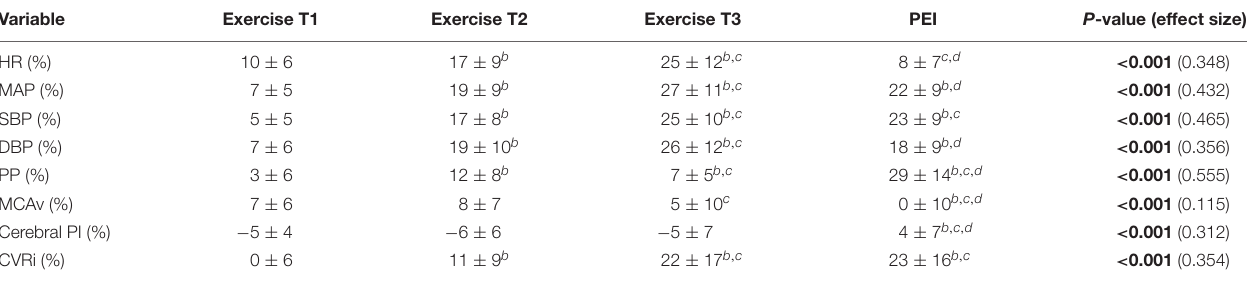
TABLE 3 | Percent change from baseline in cardiovascular and cerebrovascular variables during isometric handgrip exercise and post-exercise ischemia. Variable Exercise T1 Exercise T2 Exercise T3 PEI P -value (effect size)